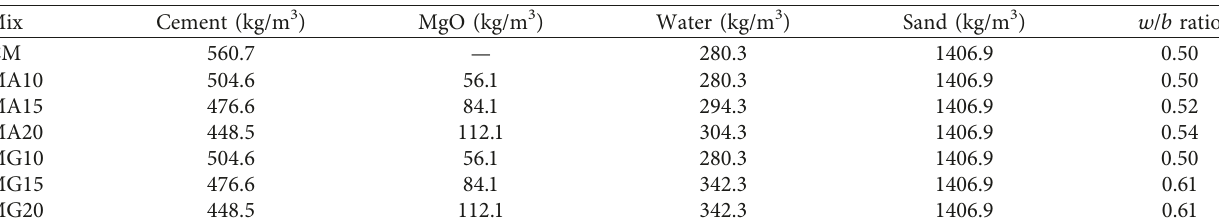
Figure 5: XRD patterns for (a) fine sand (FS) and (b) coarse sand (CS). Table 3: Composition of